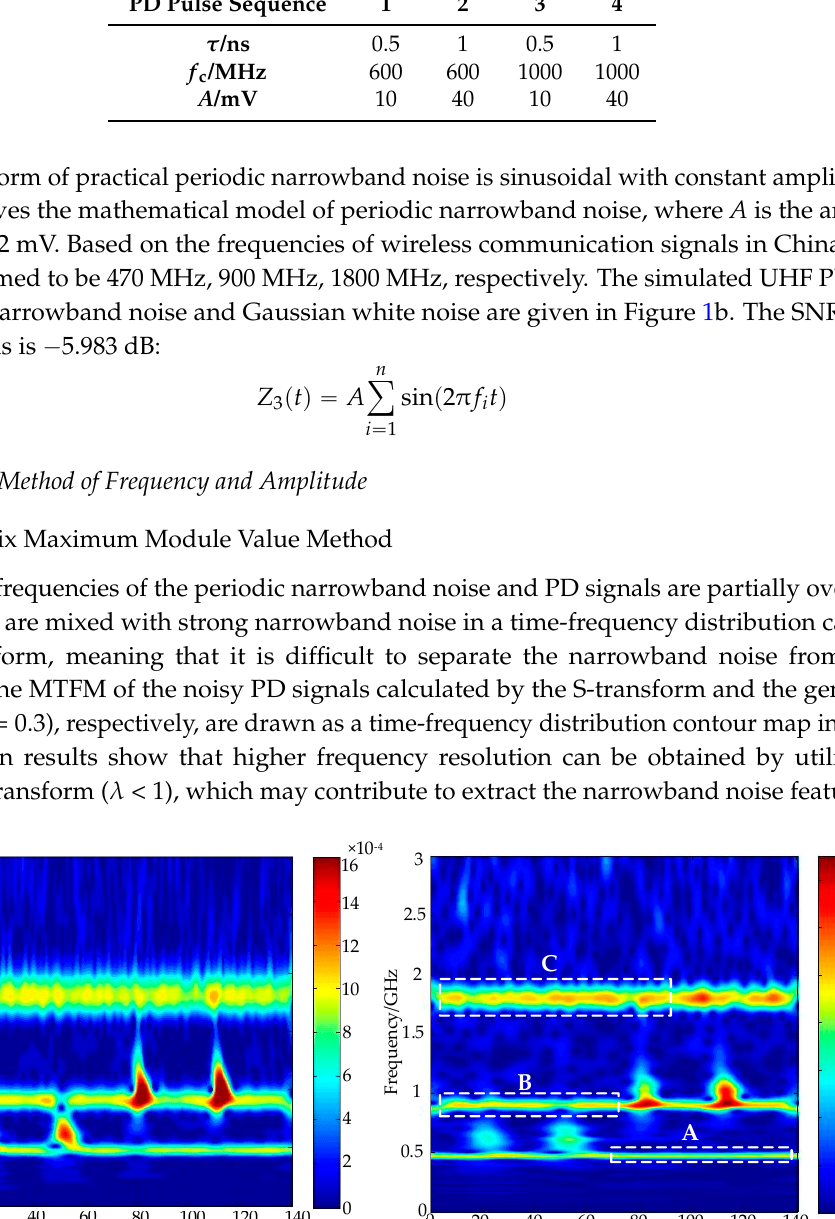
Table 1. Parameters of the simulated UHF PD signals.